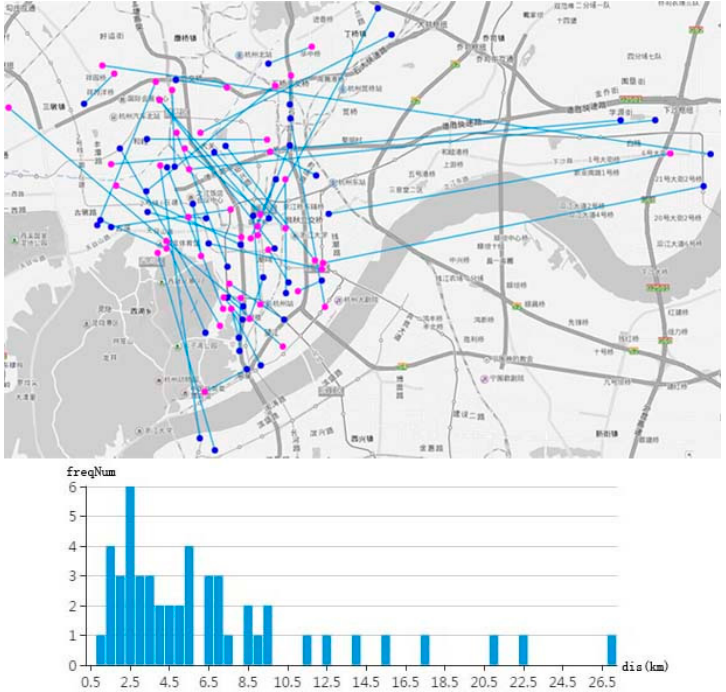
Figure 9. Visualization of multiple users’ home and workplaces.